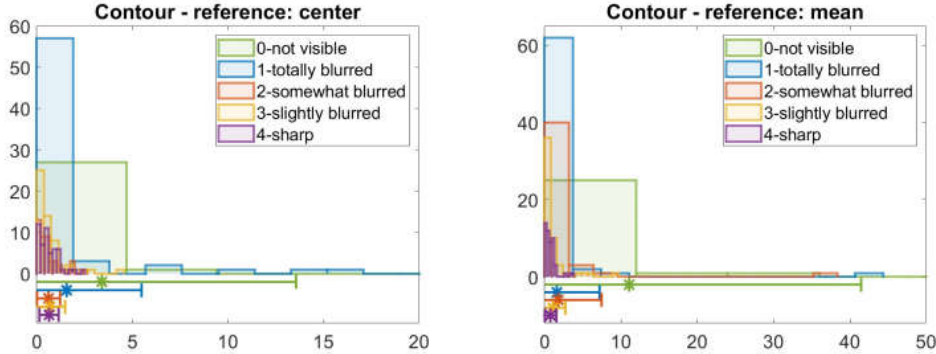
Figure 6. Histograms of the machine computed values meant to represent the attribute “contour” according to (6). The experts’ knowledge-based classification of the images has the five categories listed in the legend of the plot. Each expert category has one histogram. The bottom part of the image gives the mean value of the corresponding manual category with a marker * and the interval with length of the standard deviation left and right from the mean value is also indicated by the same color as the histogram. The distance of these intervals from the horizontal axis at 0 does not have any significance, it is only to make the intervals visible.